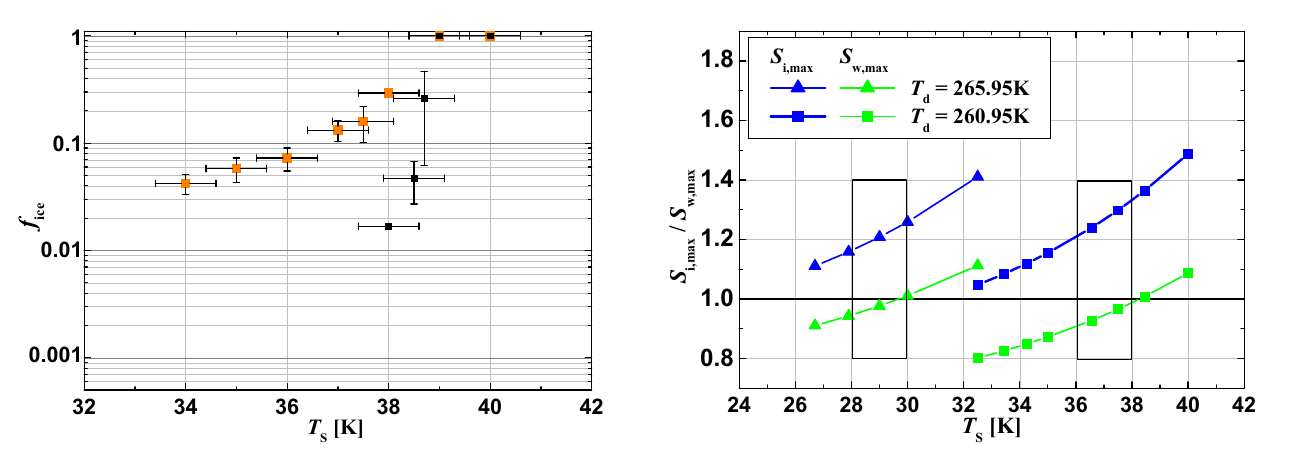
Fig. 6. Ice fraction f ice derived for pure ATD particles at different T s (orange squares) and for homogeneous freezing of highly diluted ammonium sulfate droplets (black squares).